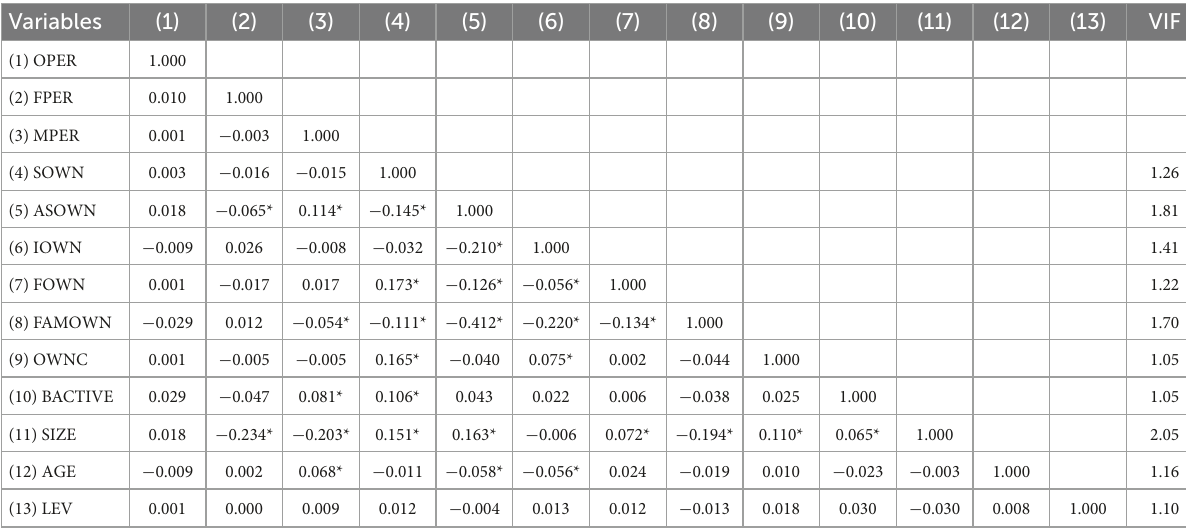
TABLE 3 Pairwise